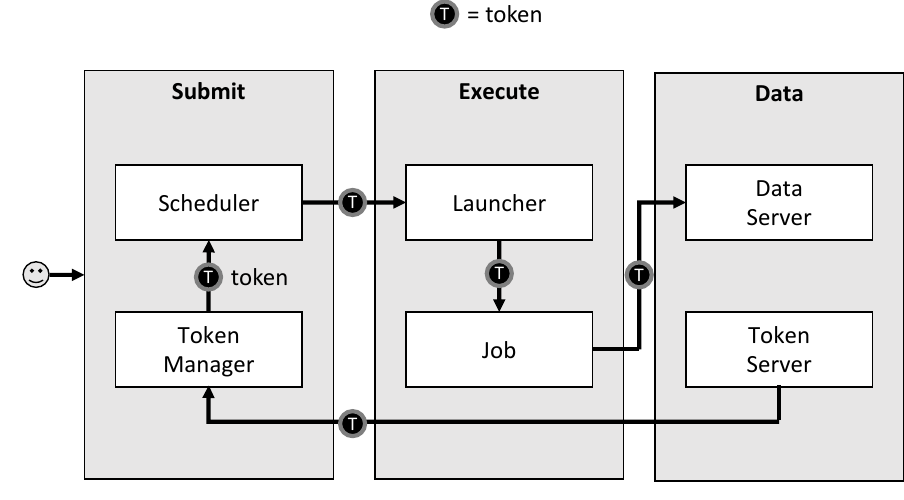
Figure 1. Token flow in a